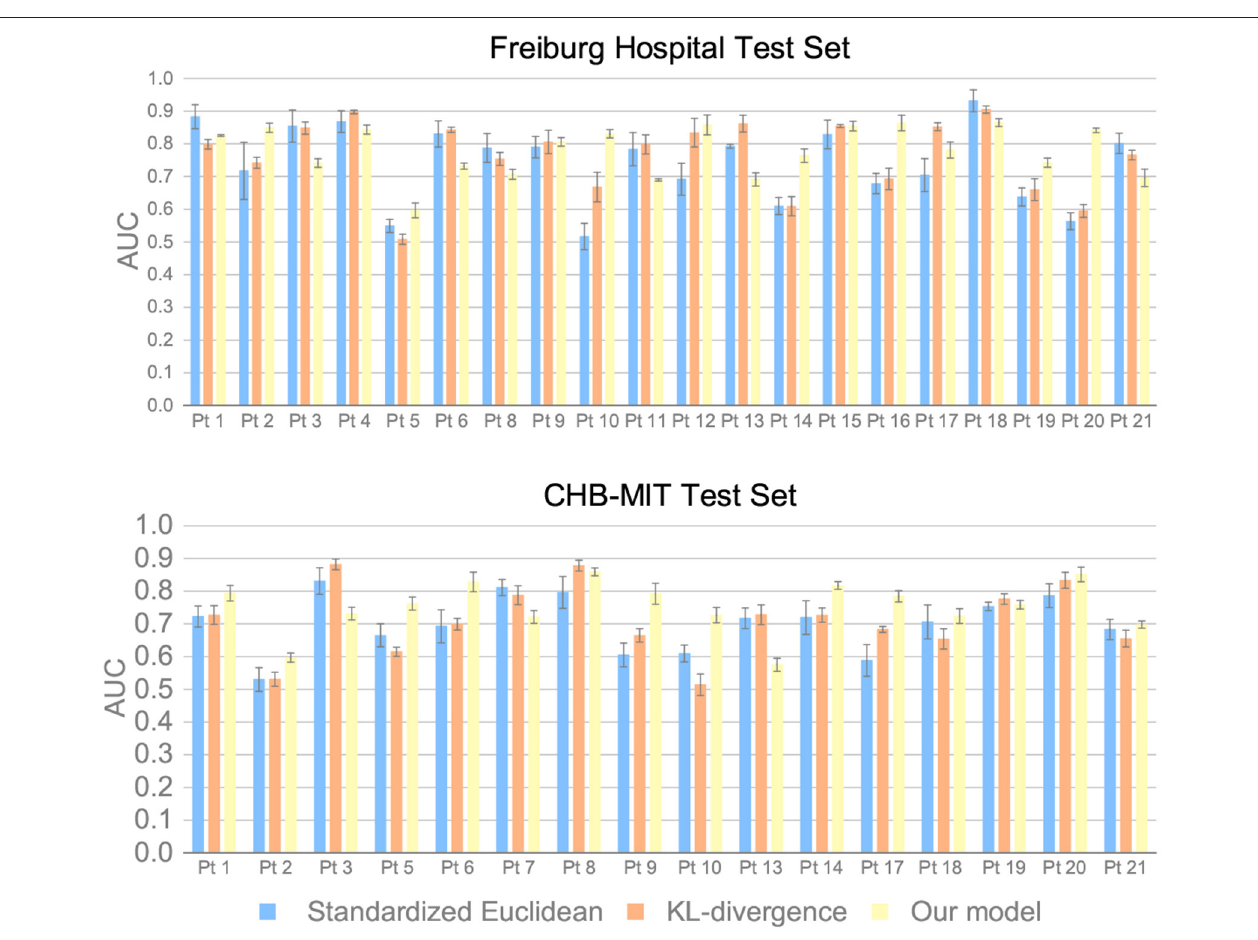
FIGURE 7 | AUC of different inter-domain distance measures on the Freiburg Hospital test set and the CHB-MIT test set.